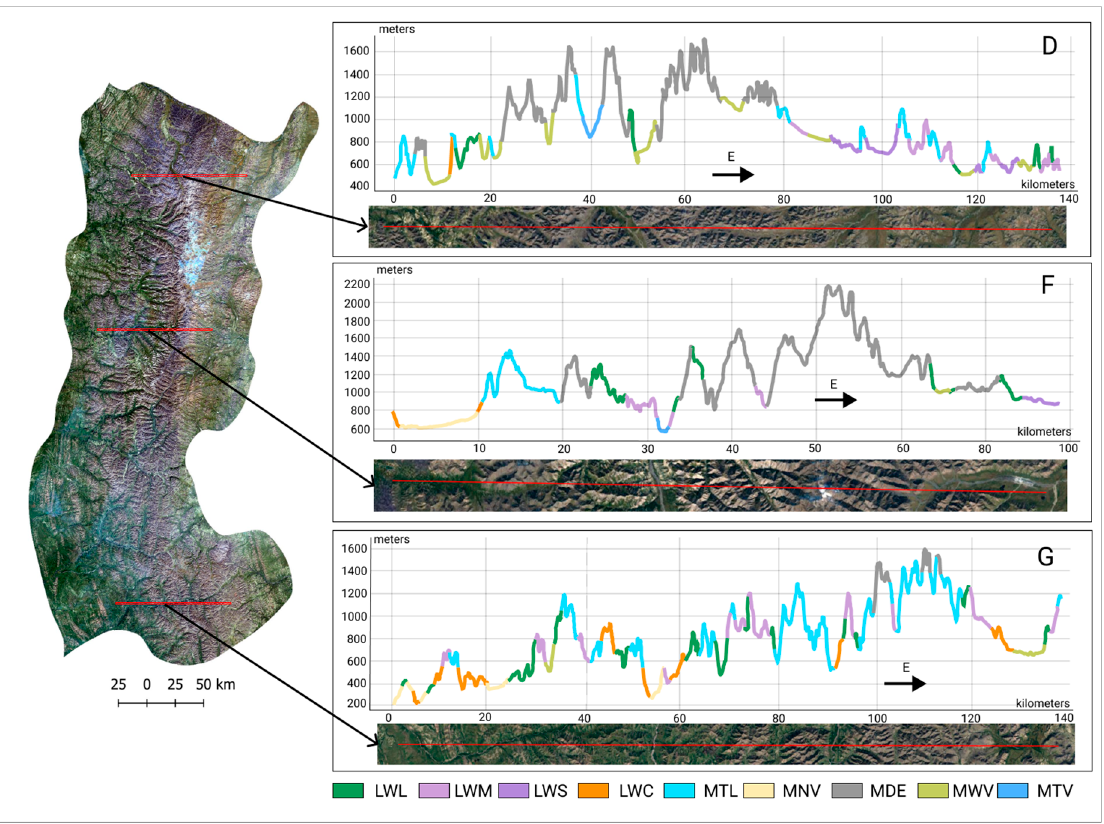
Figure 9. Hypsometric latitudinal landscape profiles of the Orulgan ridge: ( D ) (69 ◦ 08 (cid:48) 00” N), ( F ) (67 ◦ 35 (cid:48) 01.0” N), and ( G ) (66 ◦ 19 (cid:48) 51.0”